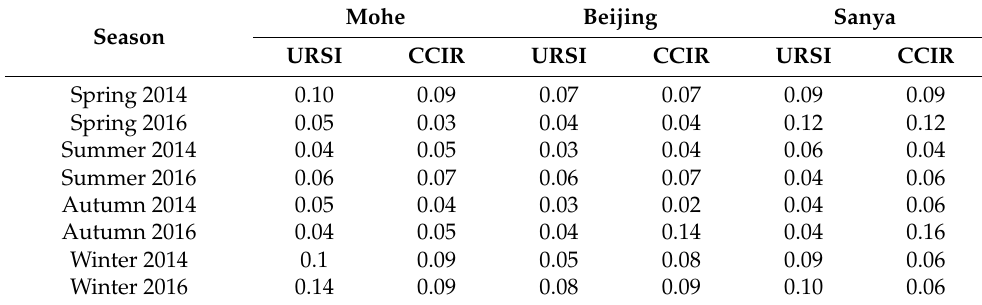
Table 4. Daily average MARE values of IRI-2016 URSI and CCIR predicted foF2 from the foF2 ionosonde observed in the four different seasons for the years 2014 and 2016 at Mohe, Beijing and Sanya over China. Mohe Beijing Sanya Season URSI CCIR URSI CCIR URSI